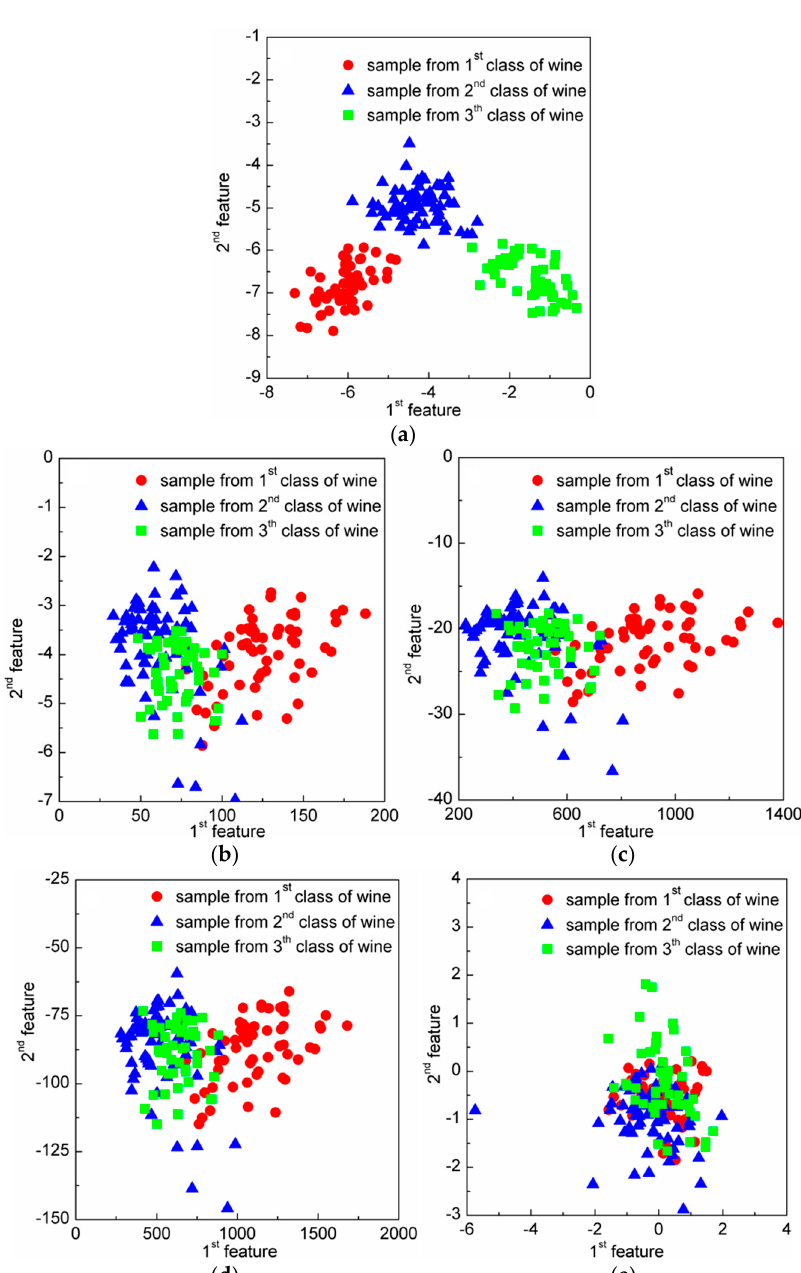
Figure 4. The two-dimensional results of the wine data using different dimension-reduction (DR) methods: ( a ) CRC-steered discriminative projection learning method (CRC-DP); ( b ) locality preserving projection (LPP); ( c ) neighborhood preserving embedding (NPE); ( d ) principal component analysis (PCA); ( e ) sparsity preserving projection (SPP).